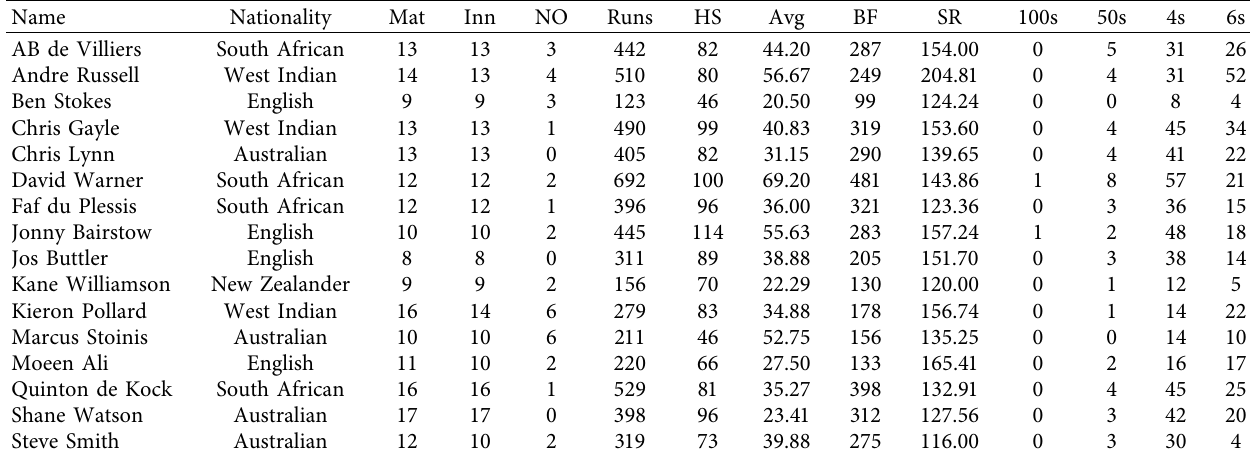
Table 3: Batsmen